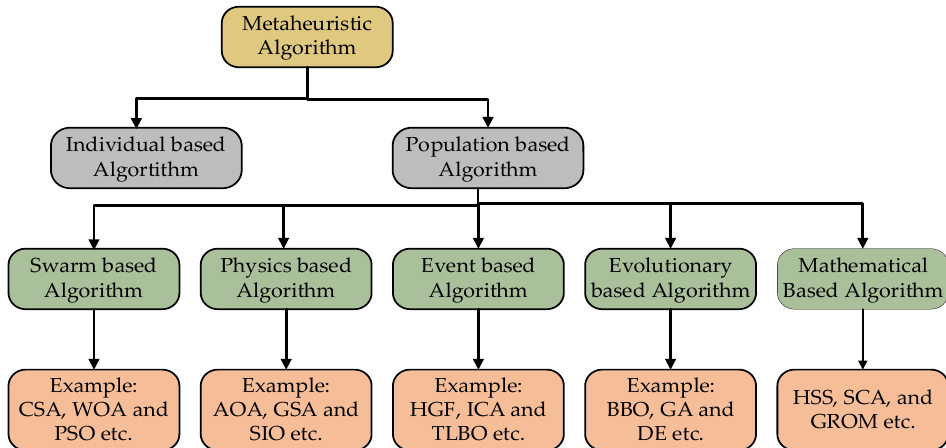
Figure 1. Classification of metaheuristic algorithms.